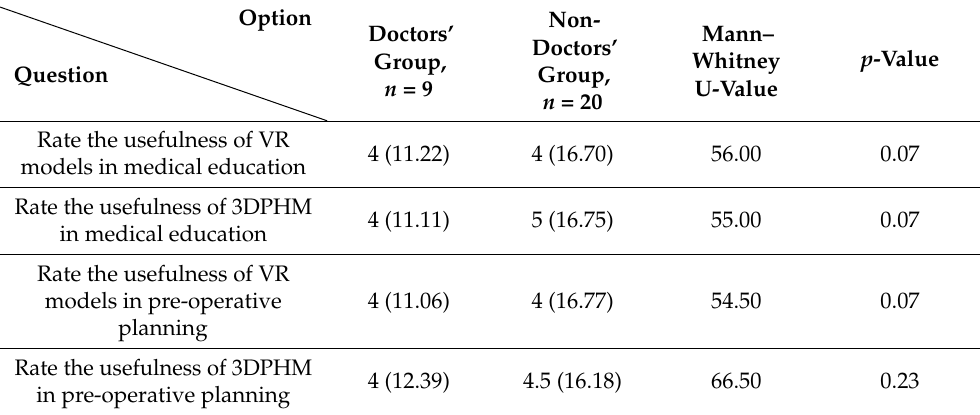
Table 3. Subgroup analysis for participants’ responses on the ratings for VR and 3DPHM. a Reprinted with permission under the open access from Lau et al.